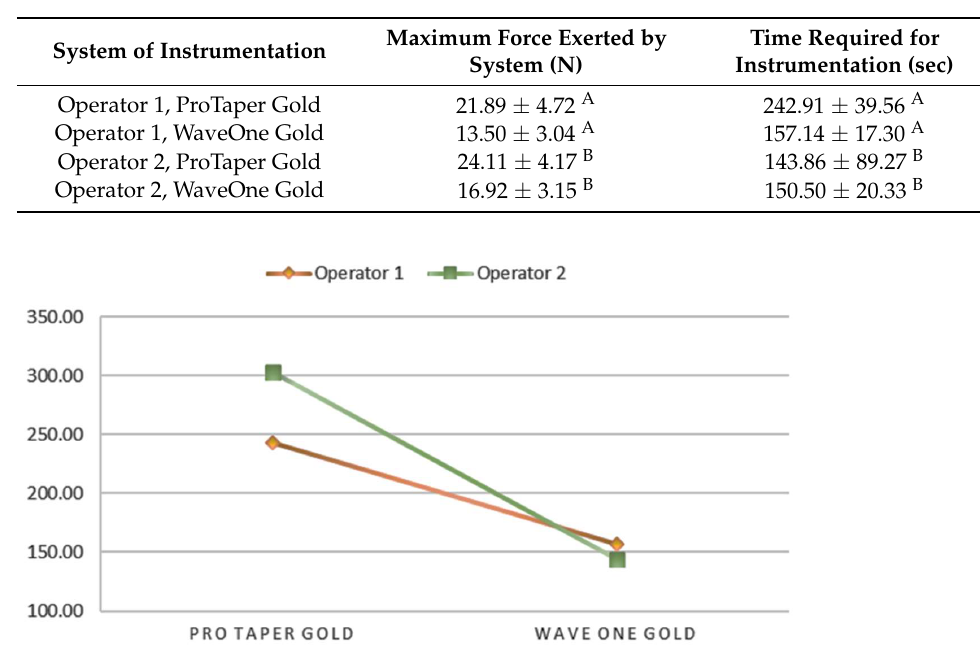
Figure A1. Graphical representation of the time (unit: seconds) needed for radicular preparation plotted for operators with different systems.